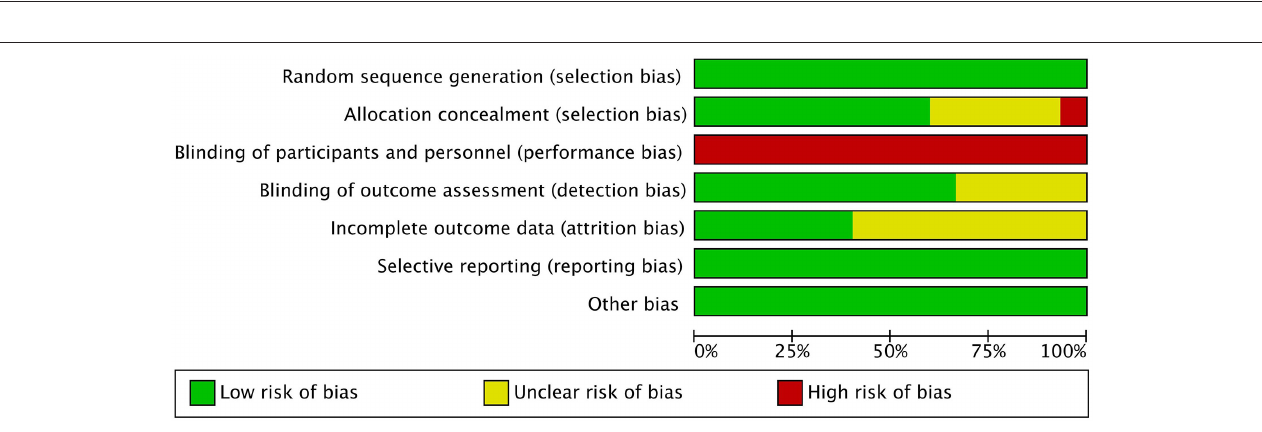
FIGURE 2 | Assessment of risk of bias with selected